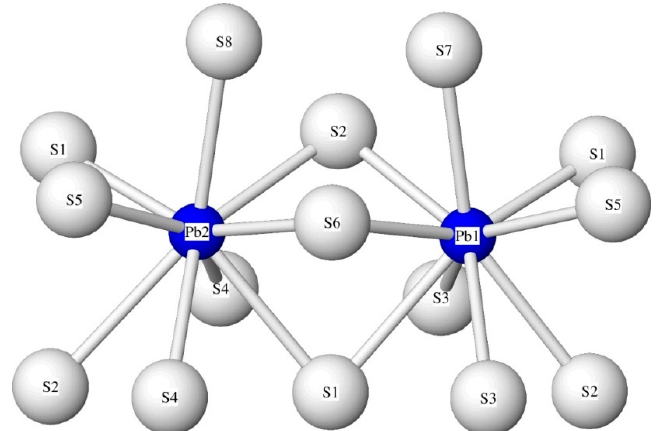
Figure 7. Coordination polyhedra for the Pb1 and Pb2 sites (CN = 9). Sulphur sites S1, S2, and S6 are shared, and the Pb–S bond lengths for S5, S6, S7, and S8 are slightly affected by substitutions at the Me3, Me5, and Me6 sites.